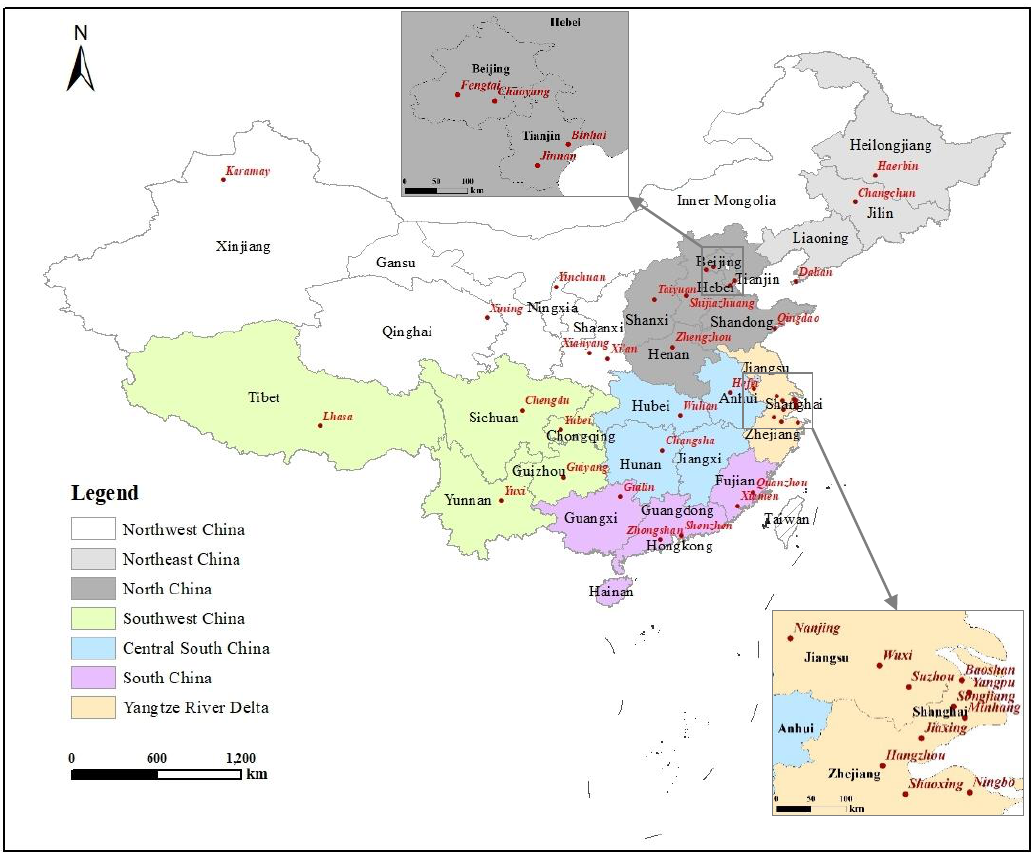
Figure 1. Seven subregions and 40 cities (or districts) surveyed in China. Note : Red dots on the map indicate the cities surveyed. North China consists of northwestern (Xinjiang, Gansu, Qinghai, Ningxia, Shaanxi, and Inner Mongolia), northeastern (Heilongjiang, Jilin, and Liaoning), and northern areas (Beijing, Tianjin, Hebei, Shandong, Shanxi, and Henan). South China includes southwestern areas (Chongqing, Sichuan, Guizhou, Yunnan, and Tibet), central–south (Anhui, Hubei, Jiangxi, and Hunan), and southern areas (Fujian, Guangdong, Guangxi, and Hainan) and the Yangtze River Delta (Jiangsu, Shanghai, and Zhejiang).